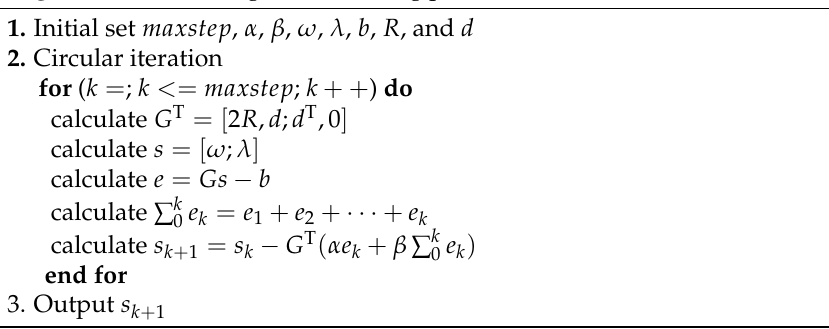
Algorithm 1: IEGD algorithm solving